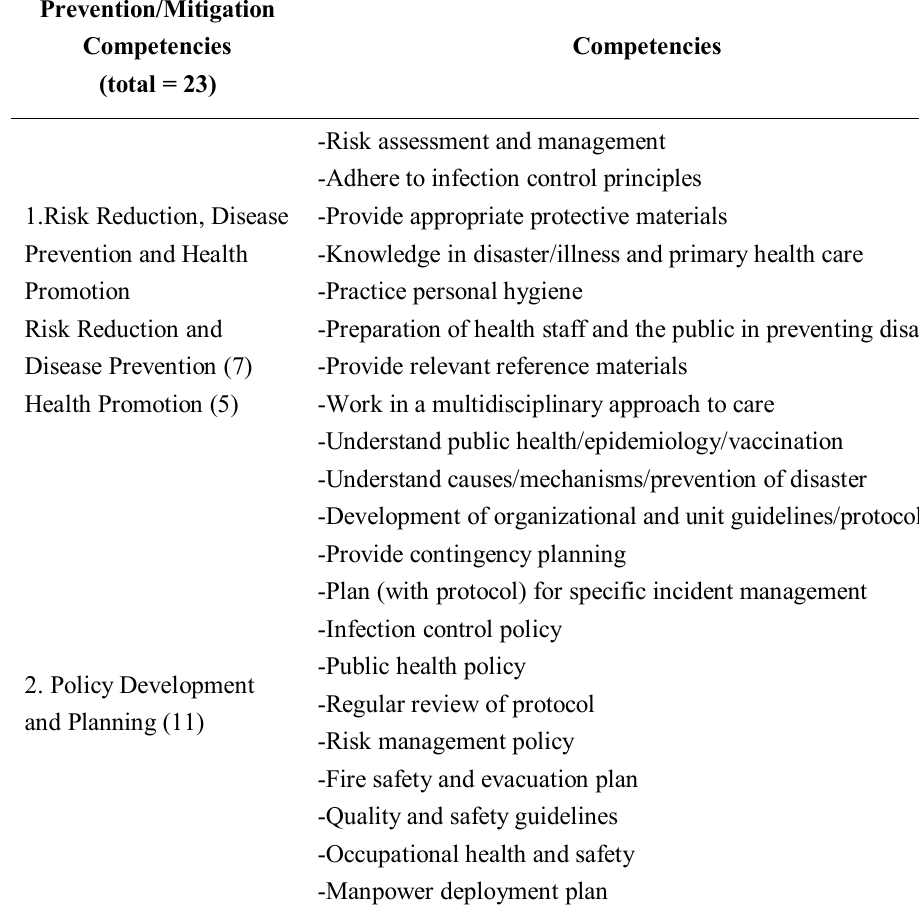
Table 2. Hong Kong nurses‟ perceived competencies for disaster care reported in focus group interviews ( n = 15) and written inquiry ( n = 30). The 4 areas and 10 domains of the ICN Framework of Disaster Nursing